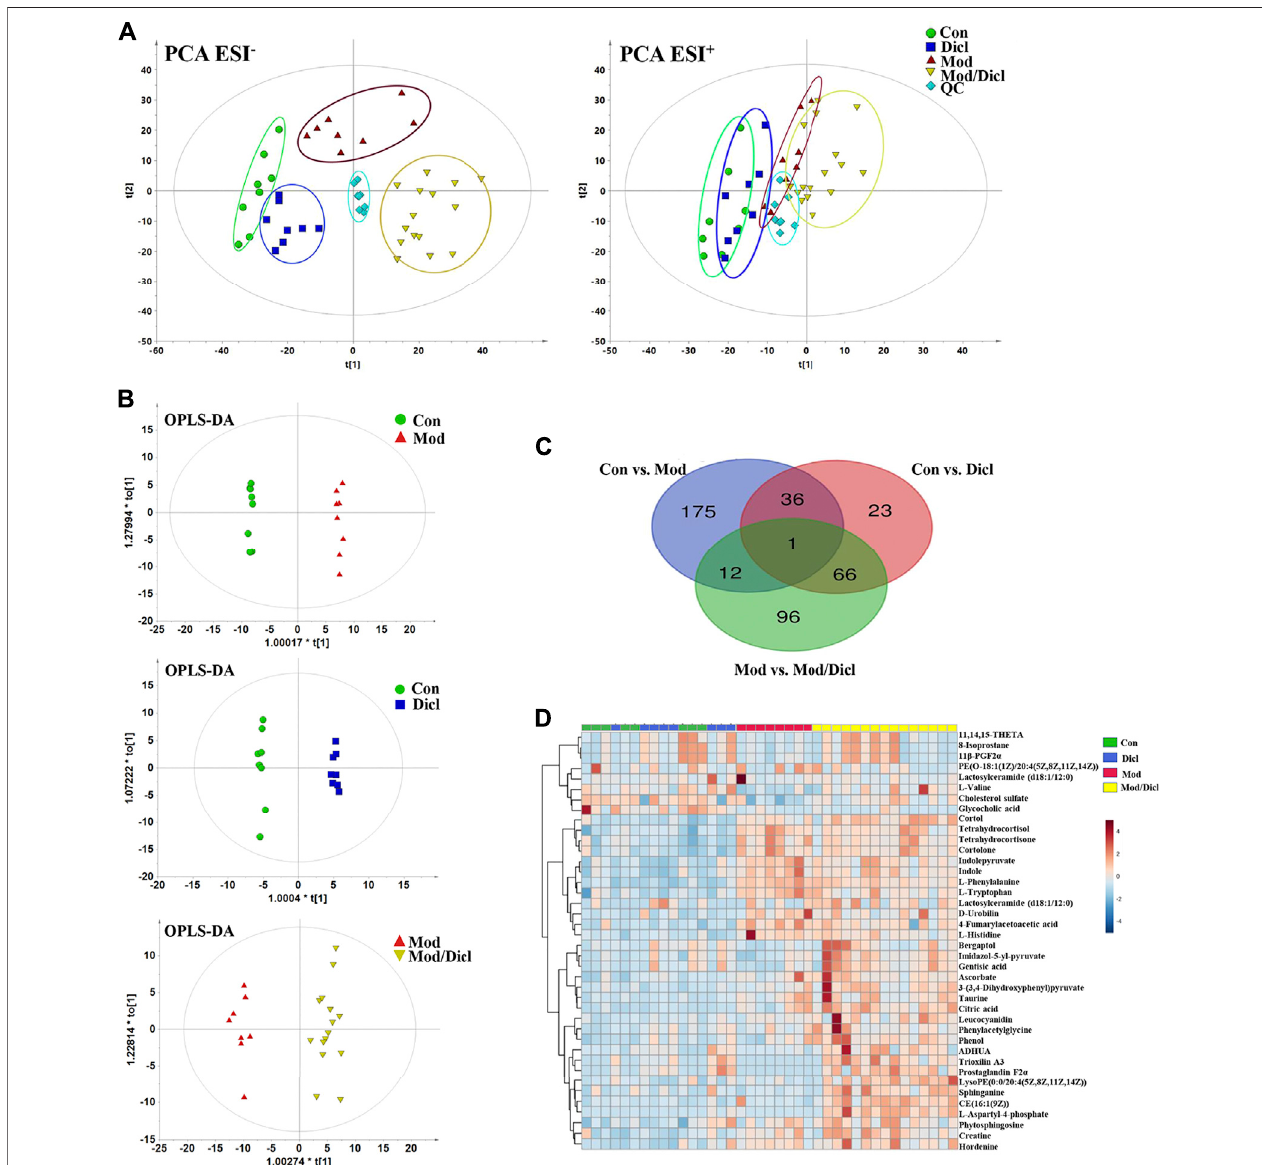
FIGURE 3 | Metabolomic pro fi le analysis of Dicl-IDILI in rats. (A) The PCA score plots for different experimental groups of either negative (left) or positive (right) ESI modes, respectively. Therats wererandomizedinto fourgroups asfollows: theCongroup (n (cid:1) 8), Diclgroup(n (cid:1) 8), Mod group(n (cid:1) 8), and Mod/Diclgroup (n (cid:1) 15). (B) OPLS-DA score plots of the paired groups (Con vs . Mod, Con vs. Dicl, and Mod vs . Mod/Dicl). (C) The number of shared and unique metabolites visualized in the Venn diagram for Con vs. Mod, Con vs. Dicl, and Mod vs. Mod/Dicl. (D) The clustered heat map of the 40 metabolites with signi fi cantly different expressions among the control, Mod, Dicl, and Mod/Dicl groups. The colors in the heat map indicate increased (red) or decreased (blue) relative metabolite contents.